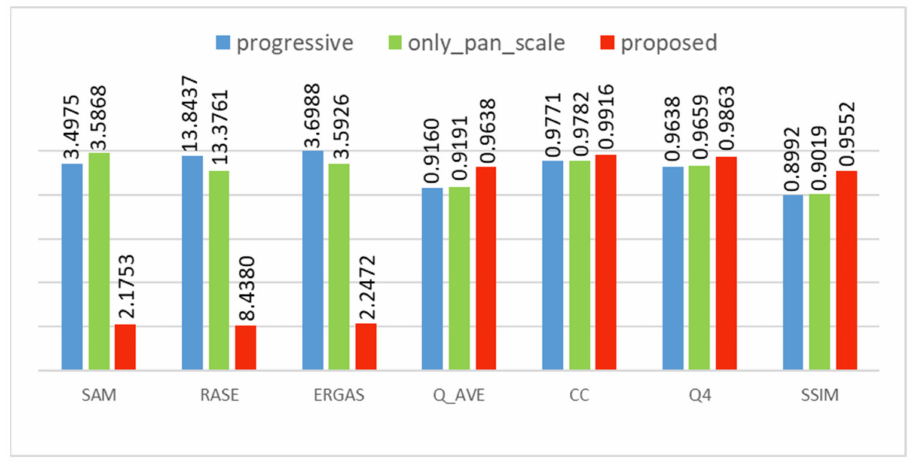
Figure 16. The effect of the feature-travel route on the result of pansharpening